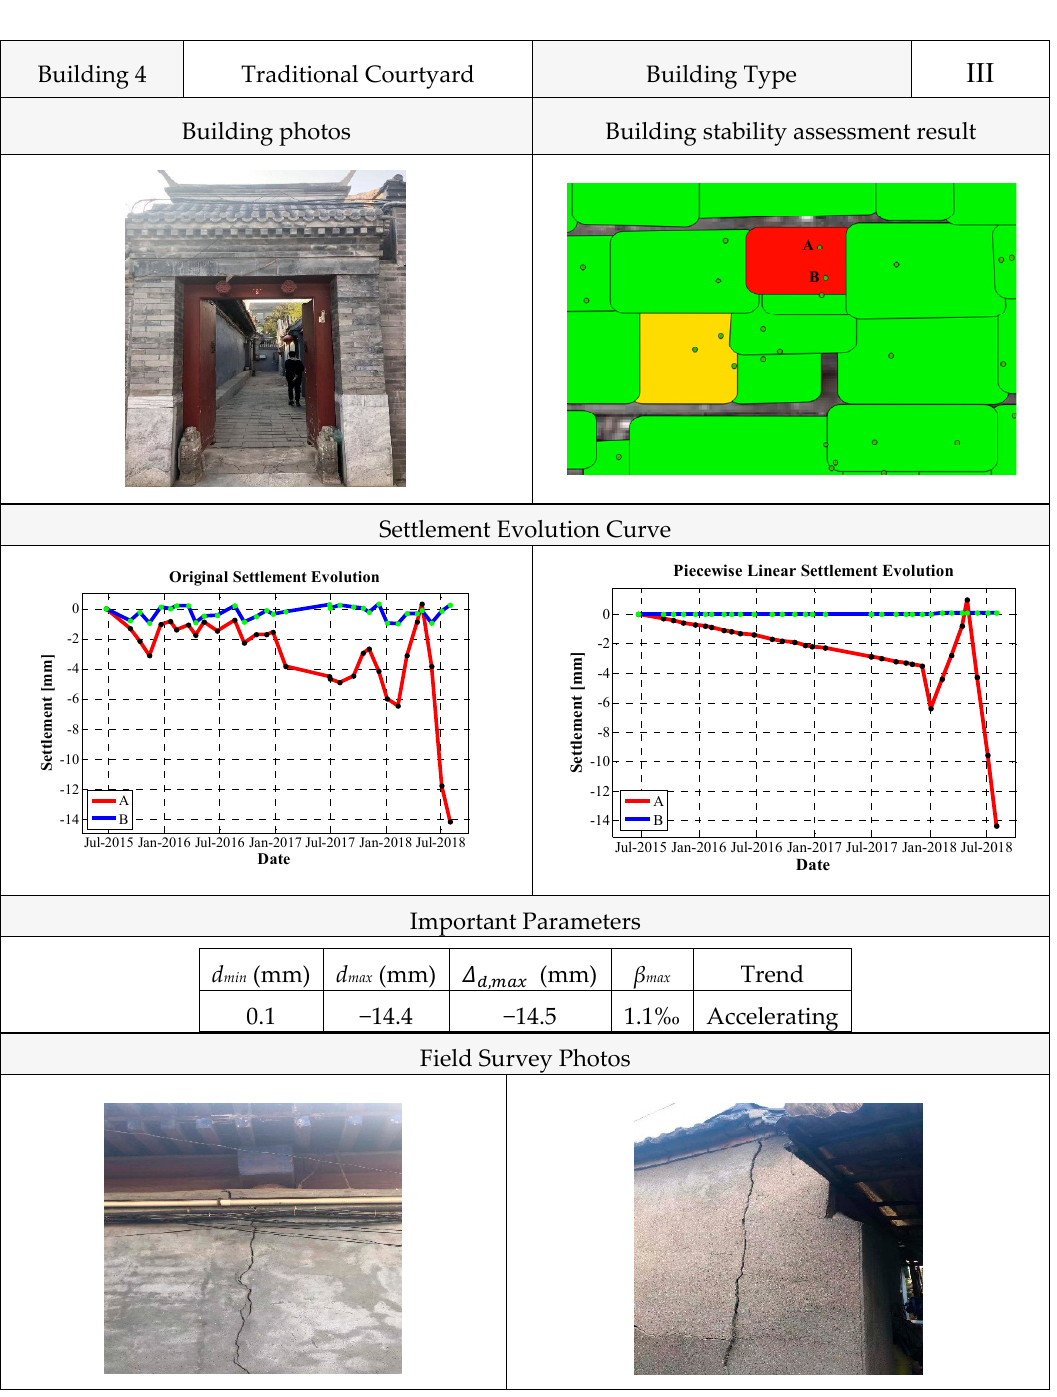
Figure 20. Example of analysis results: Building 4.